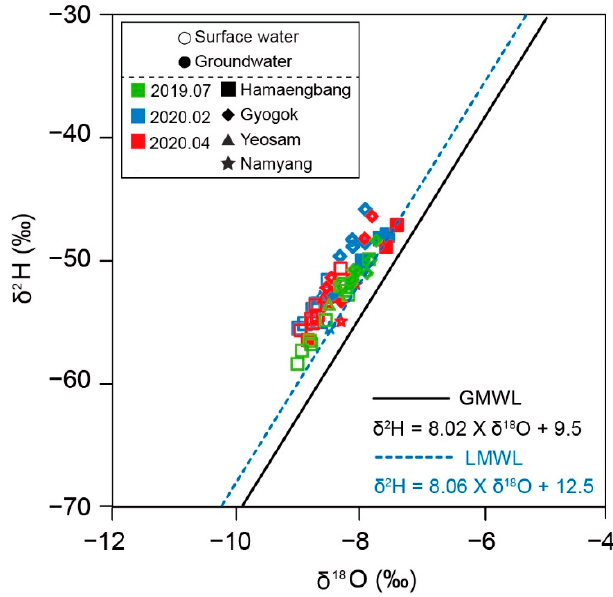
Figure 7. Relationship between the δ 18 O and δ 2 H values in surface water and groundwater. Water 2020 , 12 , x FOR PEER REVIEW